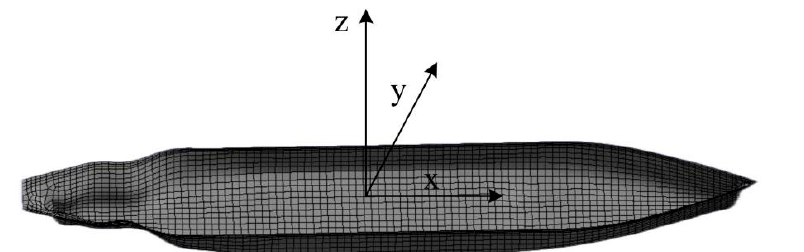
Figure 7. Ship wet-surface-element mesh.